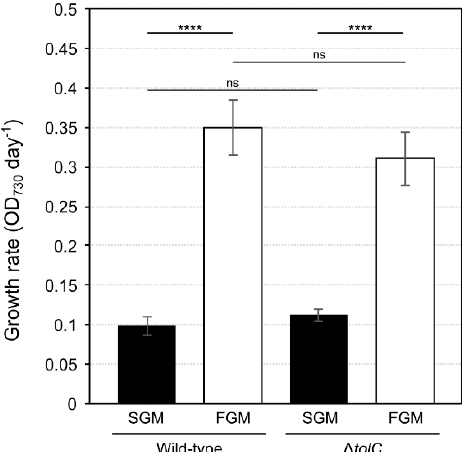
Figure 1. Growth rates of Synechocystis sp. PCC 6803 wild-type and ∆ tolC mutant strains cultivated in slow- (SGM, black bars) or fast-growth mode (FGM, white bars). The presented rates were determined based on the respective culture’s initial and final optical densities (OD 730 ), and on for 4 days of cultivation. The error bars indicate standard deviation corresponding to 6 independent biological replicates. **** p < 0.0001; ns: not statistically significant difference.